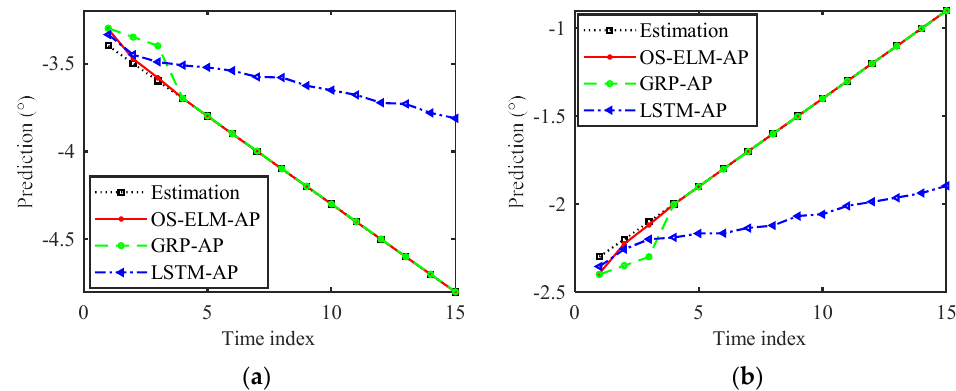
Figure 12. Online angle prediction results for ( a ) Path 1 and ( b ) Path 2.